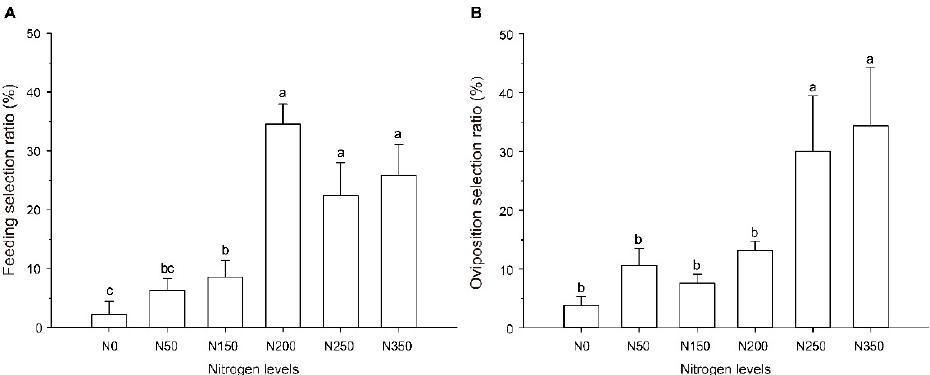
Figure 1. Feeding and oviposition preference of S. furcifera on rice of different nitrogen levels. ( A ) Feeding preference of S. furcifera on rice of different nitrogen levels. Feeding selection ratio of each nitrogen fertility level is expressed as a percent of the adults settling on a specific fertilizer level plant. ( B ) Oviposition preference of female on rice of different nitrogen levels. Oviposition selection ratio of each nitrogen fertility level is expressed as a percent of the eggs laid on a specific fertilizer level plant. In panels A and B , values (means ± SE) labeled with different letters are significantly different at p < 0.05 (one-way ANOVA, LSD multiple range test, p < 0.05). N0, N50, N150, N200, N250, and N350 represent the rice plants grown from the six nitrogen fertility levels (0, 50, 150, 200, 250, and 350 kg/ha), respectively.